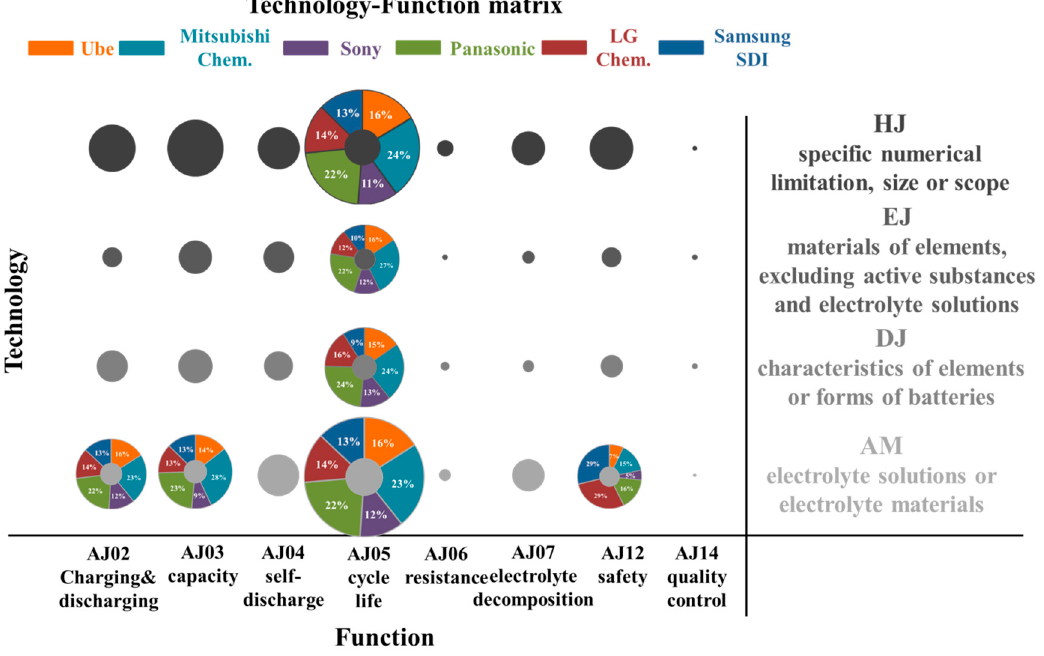
Figure 4. Bubble chart of the technology-function matrix.